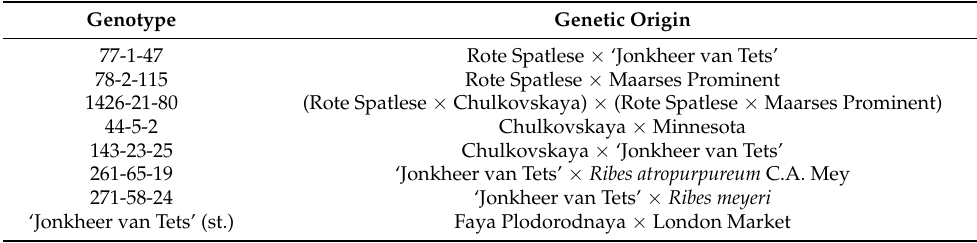
Table 2. Genetic origin of the selected red currant genotypes.